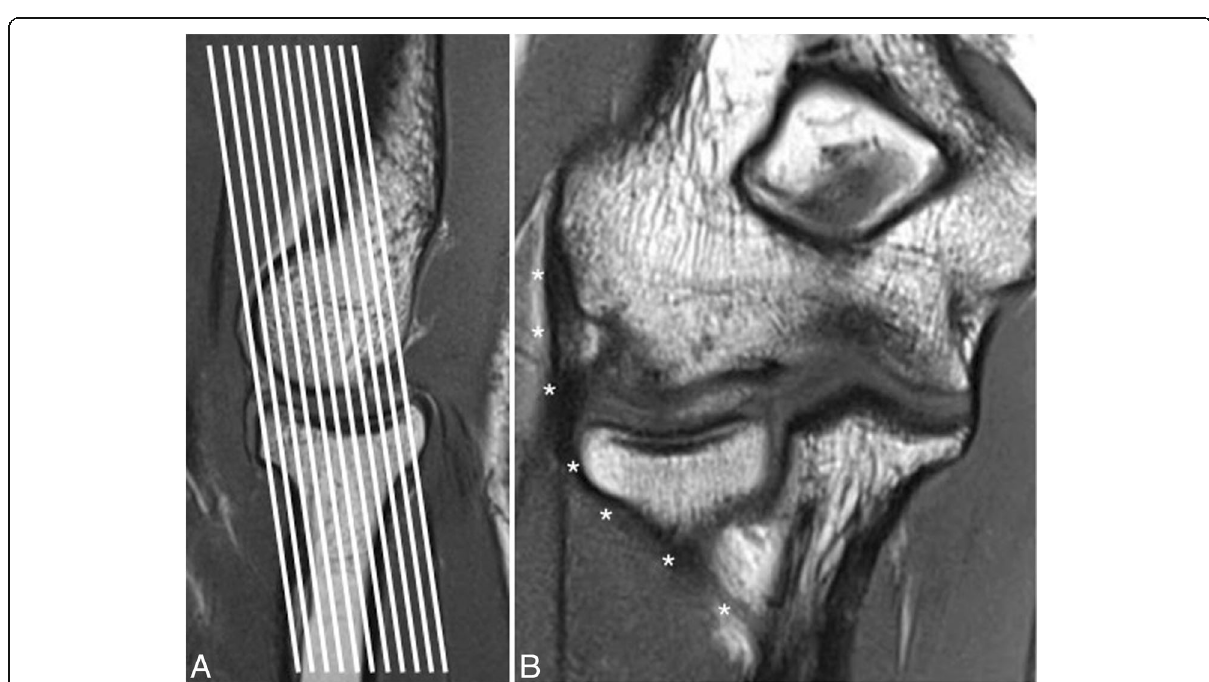
Fig. 1 Modified oblique coronal plane of the elbow used to optimally visualize the collateral ligaments. a Sagittal T1-weighted MRI showing the modified oblique coronal plane (multiple white lines) oriented 20 – 30° posterior to the long axis of the humeral diaphysis. b Coronal T1-weighted MRI showing the intact lateral ulnar collateral ligament (white asterisks)